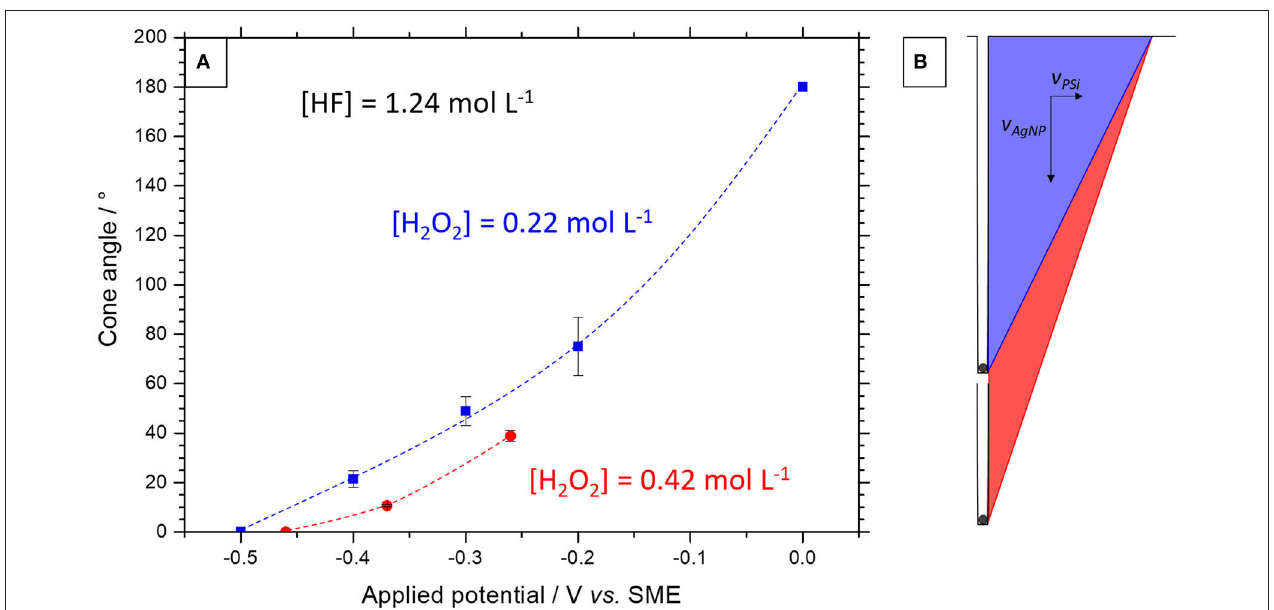
FIGURE 7 | (A) Opening angle of the cone-shaped macropores obtained at different anodic potentials during MACE performed in 1.24mol L − 1 HF for two different H 2 O 2 concentrations corresponding to the experiments presented in Figure 6 (0.22mol L − 1 ) Figure 9 (0.42mol L − 1 ). The error bar represents the standard deviation for about ten measured macropores. The dashed lines are guides for the eyes. (B) Scheme of a cone-shaped pore formation by combined MACE and porous silicon anodic formation with etch rates V AgNP and V PSi , for low and high H 2 O 2 concentrations (blue and red half-cones, respectively).